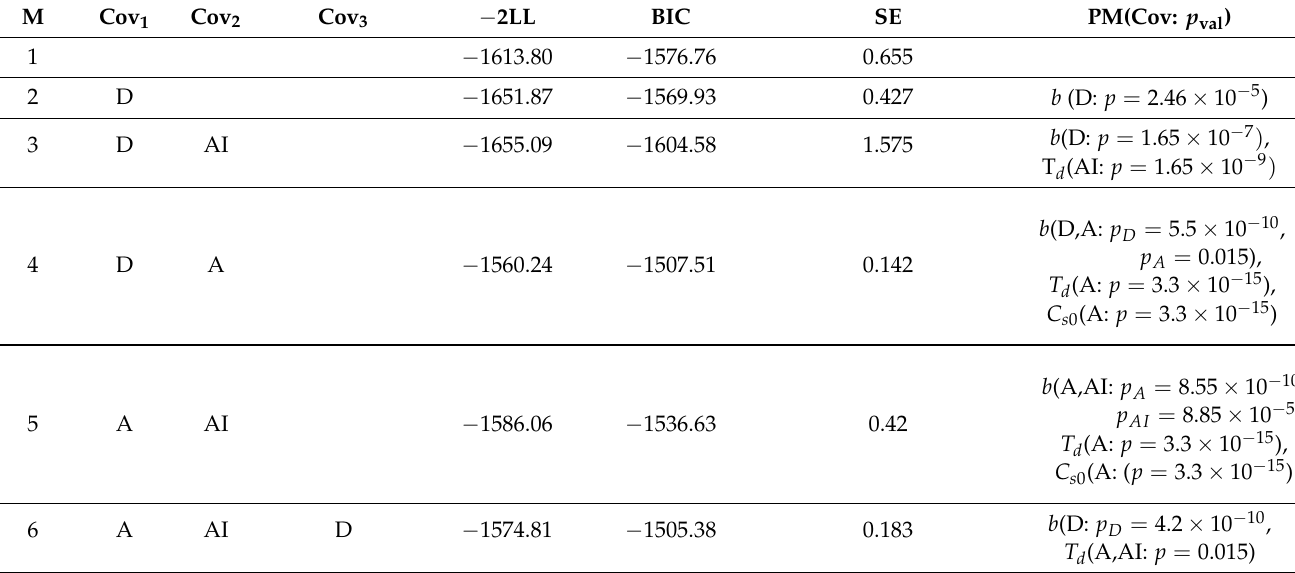
Table 1. Effects of the covariates on the parameters of model (6). M: model, PM: parameters of model (6) significantly influenced (the specific covariate is reported in square bracket), A: age, D: dyslipidemia, AI: aortic insufficiency. For each model, it is reported the effect of each covariate (in square brackets) on the parameters, and the associated p value computed via Wald’s test, and corrected for multiple tests using the